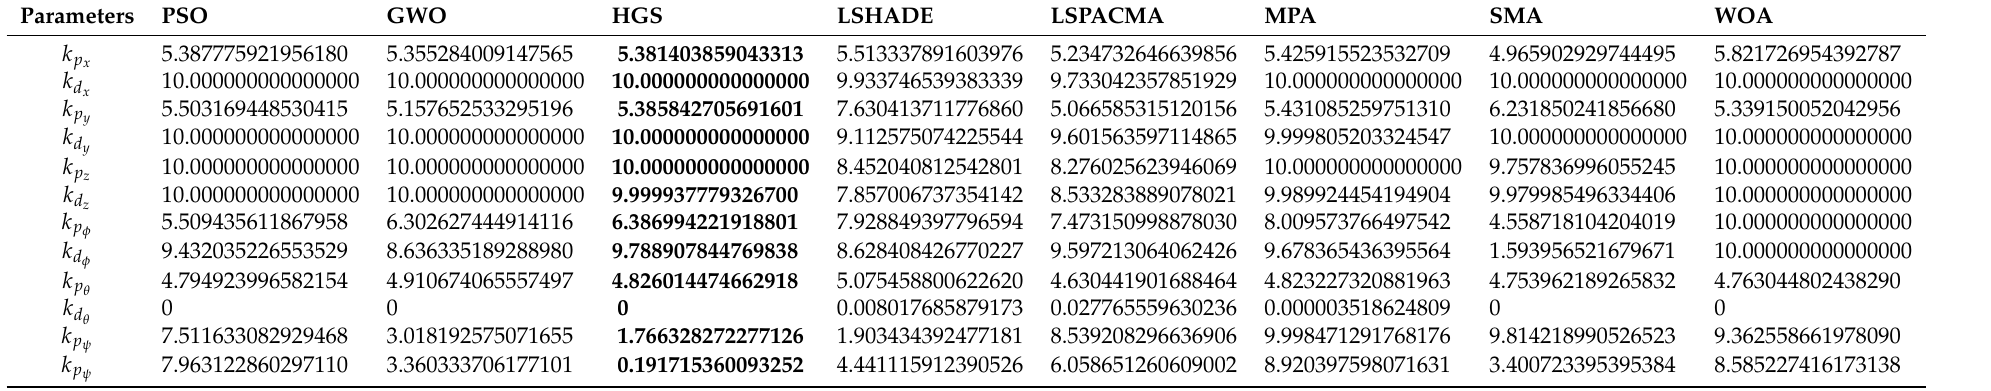
Table 6. The parameter estimation of metaheuristic algorithms with 40 individuals, 20 evolutions and 30